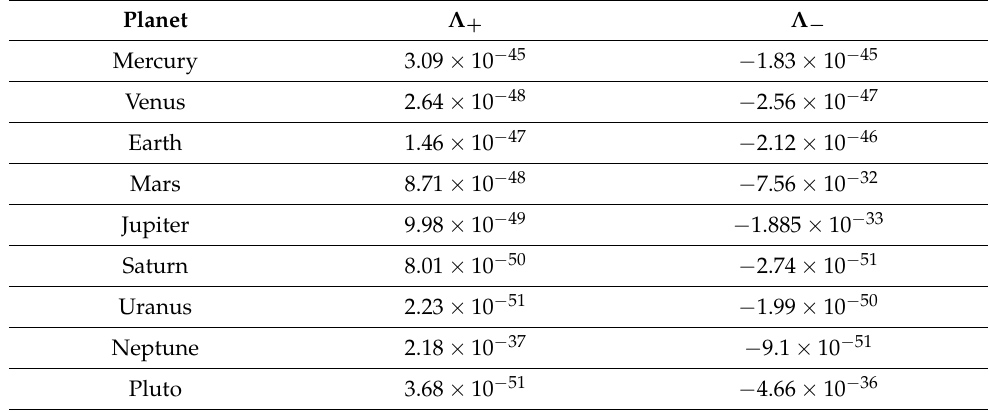
Table 7. Theoretical values for Λ